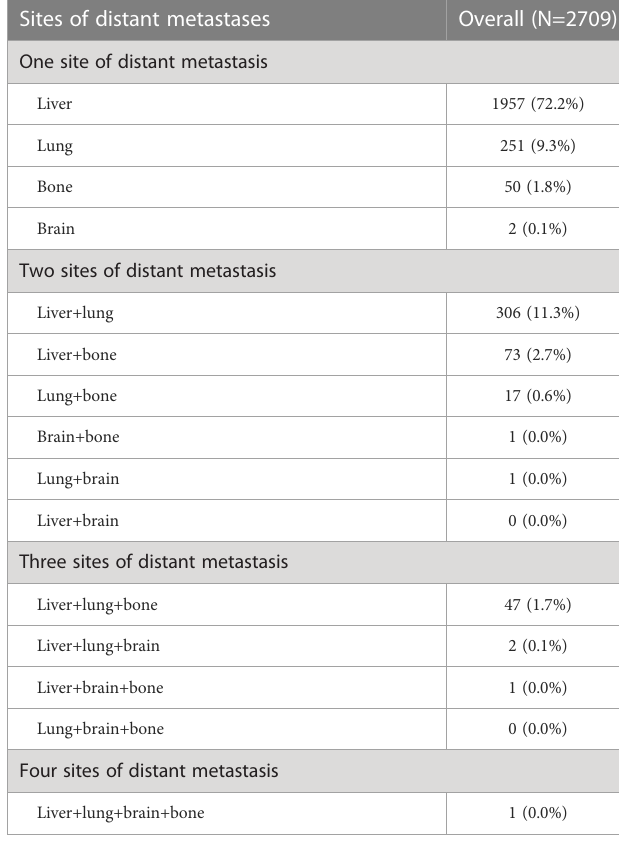
TABLE 3 Patterns of distant metastases for the 2709 metastatic PDAC